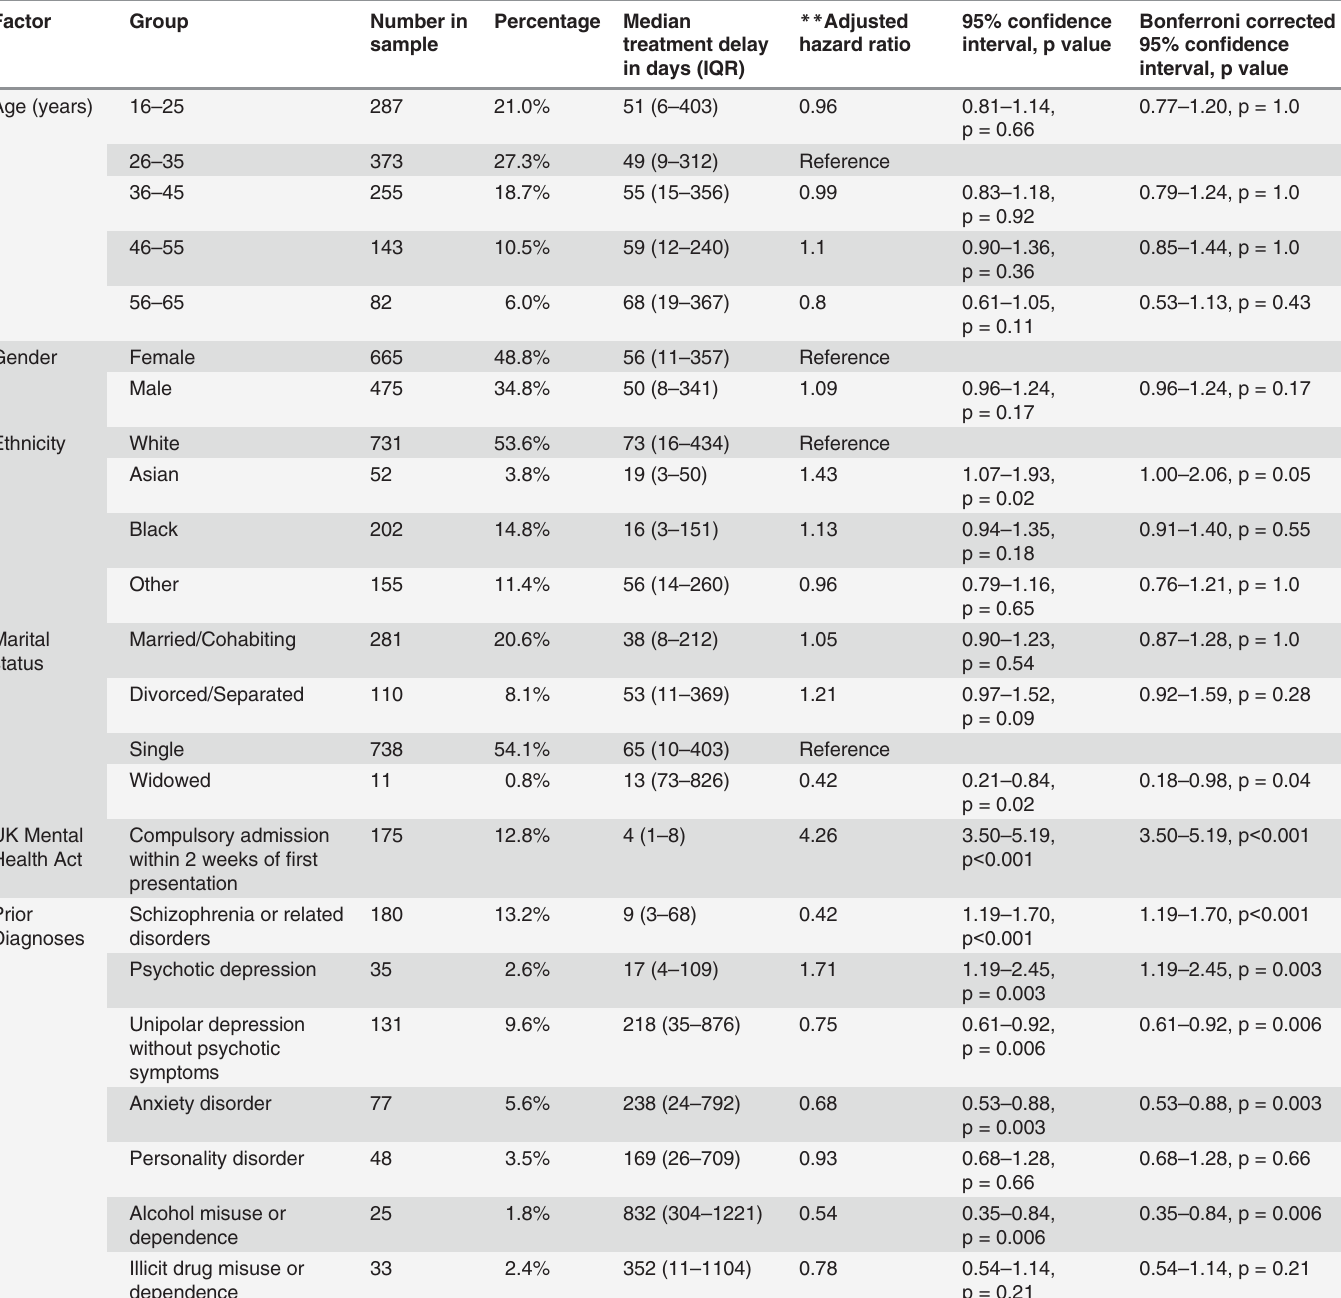
Table 7. Factors associated with bipolar disorder treatment delay only including participants with complete covariate data (n = 1140) *